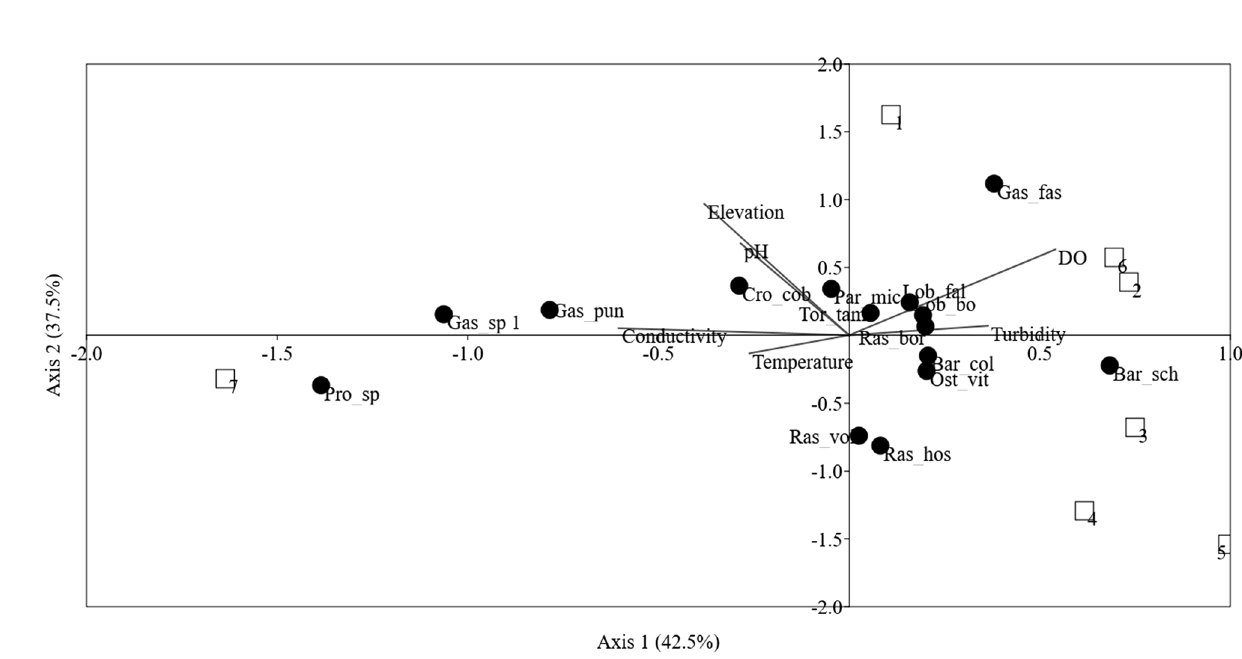
Figure 2. CCA ordination triplots of the abundance of the 15 species (> 2%) with six environmental parameters at seven groups in the Baleh River Basin. Bar_col = Barbonymus collingwoodii , Bar_sch = Barbonymus schwanenfeldii , Cro_cob = Crossocheilus cobitis , Lob_ova = Lobocheilos ovalis , Lob_fal = Lobocheilos cf. falcifer , Ost_vit = Osteochilus vittatus , Ras_bor = Rasbora borneensis , Ras_vol = Rasbora volzii , Ras_hos = Rasbora hosii